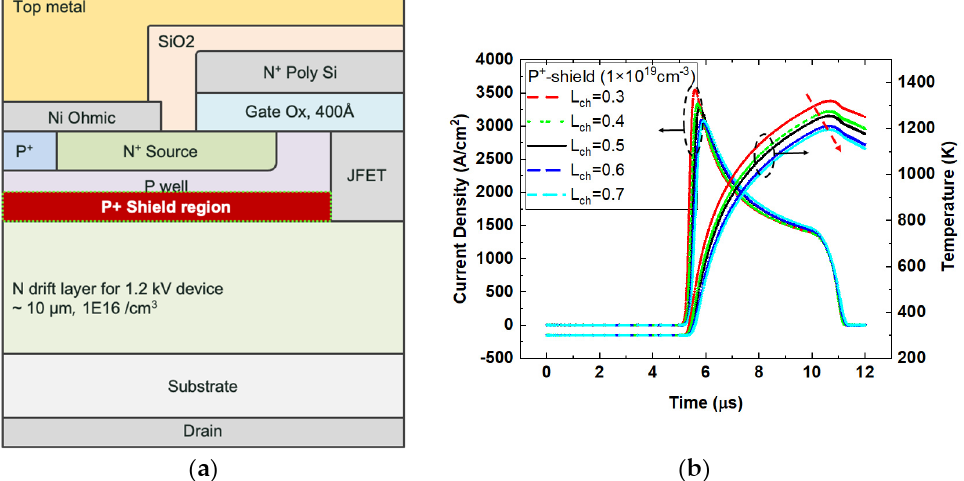
Figure 19. ( a ) Cross-sectional view of a half-cell of the MOSFET showing the highly doped P+ shielded region; ( b ) Graph showing the drain current reduction with increase in channel length when compared with Figure 19a.